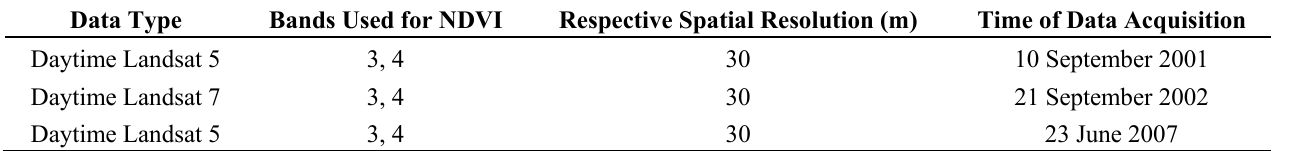
Table 2. The Landsat data used for normalized difference vegetation index (NDVI) to calculate the respective emissivities of multi-temporal satellite data in the